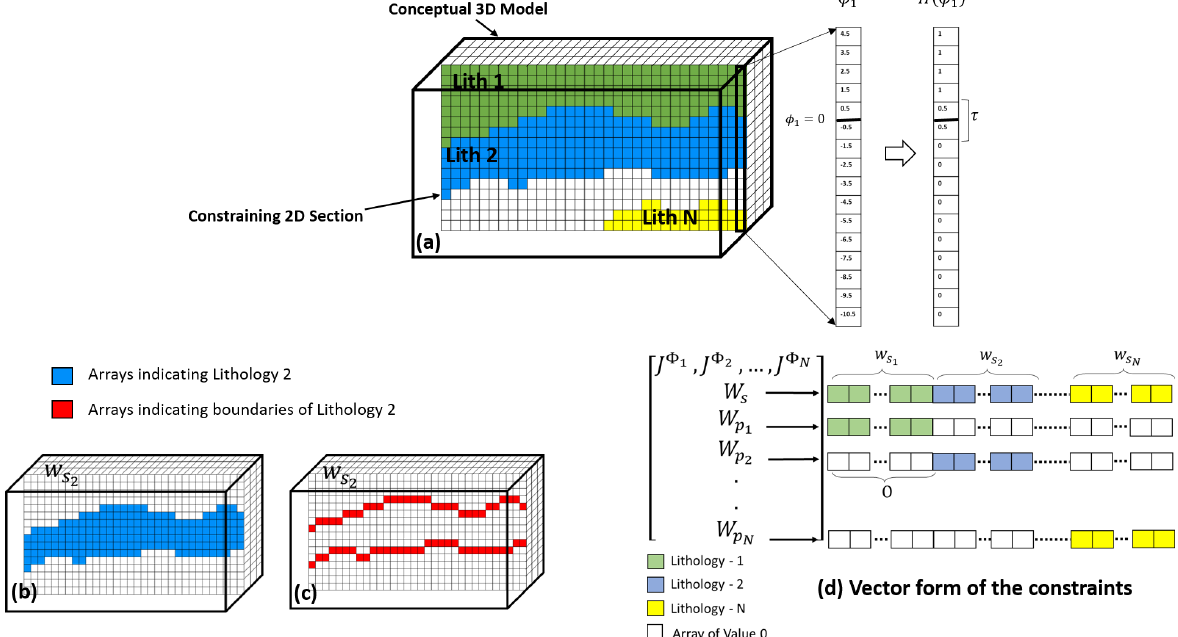
Figure 1. Illustration of the process of appending constraints to the level set problem from a sample 2D section. Panel (a) shows discretization of a conceptual 3D model and the constraining 2D section within the model that comprises N rock units; a 1D sample is extracted along the section to illustrate the calculation of signed distance and the corresponding smeared-out Heaviside function. The boundary in this case is as thick as the dimension of two cells. (b) Distribution of the constraining matrix for the entire rock unit 2 and (c) for the corresponding boundaries. Panel (d) shows the transformation of the constraints to vector forms defining the sensitivity